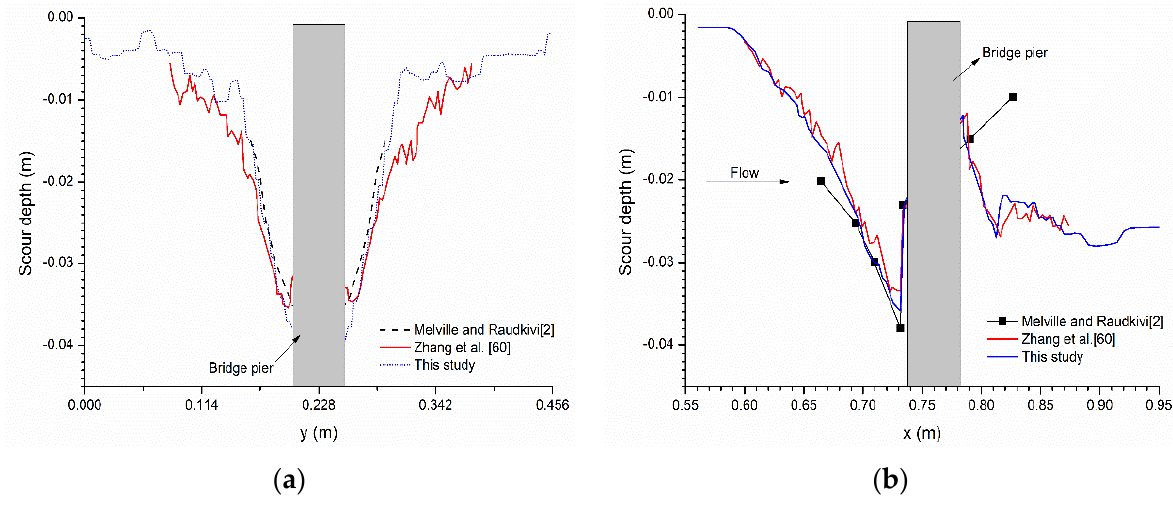
Figure 5. The comparison of scour characteristics with existing results. ( a ) Scour characteristics at x = 0.762 m. ( b ) Scour characteristics at y = 0.228 m.